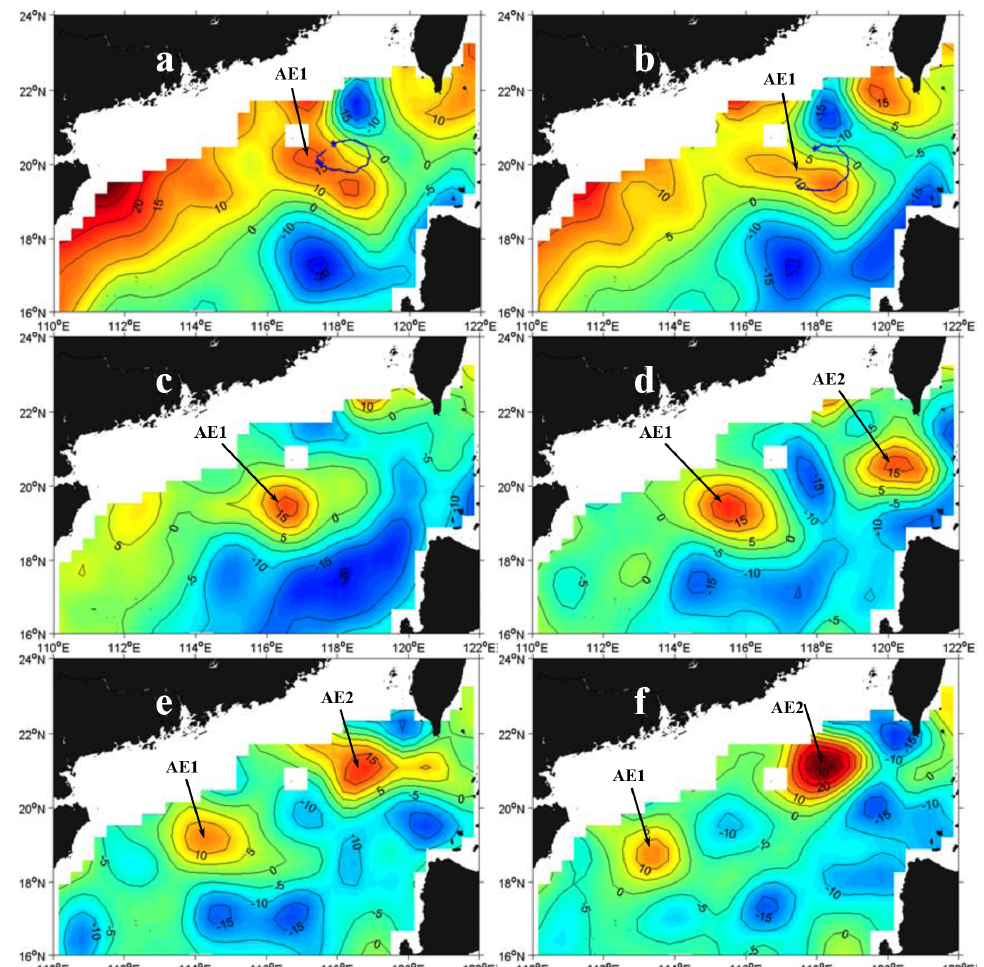
Figure 3. Snapshots of sea level anomaly (SLA) from satellite remote sensing datasets. Buoy 22918 trajectory (blue lines, blue asterisk represents the initial position of buoy, as in Fig. 4) (a) from 4 to 15 December 2003 superposed on SLA field on 10 December 2003; (b) from 16 to 23 December 2003 superposed on SLA field on 17 December 2003; SLA field on (c) 7 January 2004, (d) 21 January 2004, (e) 4 February 2004, and (f) 18 February 2004. Cited from From Wang et al.